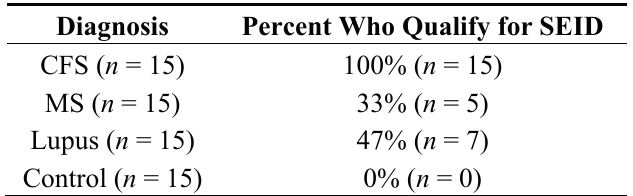
Table 1. CFS, MS, Lupus, and Control Sample n =